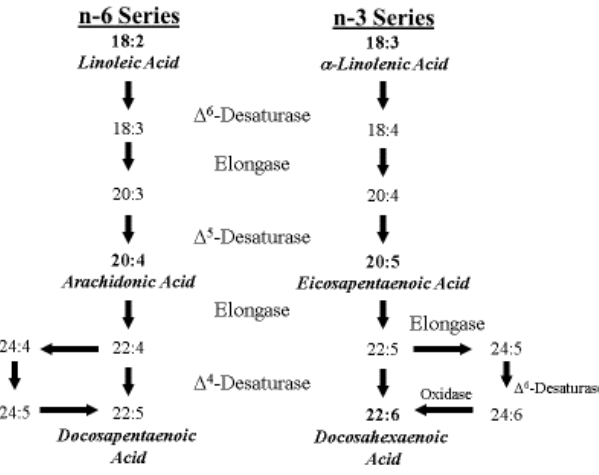
Figure 3. Metabolic pathways of linoleic and α -linolenic acid (Adapted from Lauritzen et al. [10]).